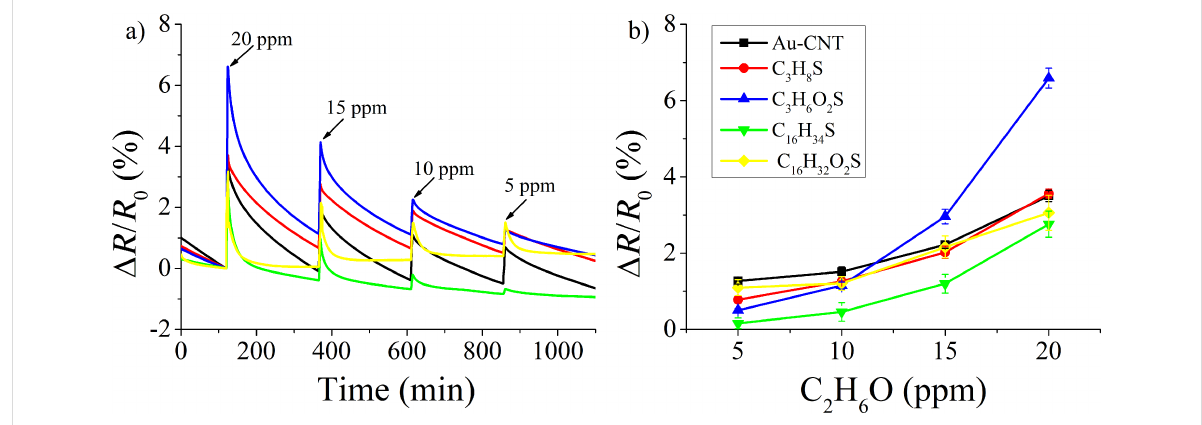
Figure 8: a) Sensor response to ethanol exposure and recovery cycles in air. b) Calibration curves for the different ethanol concentrations tested.